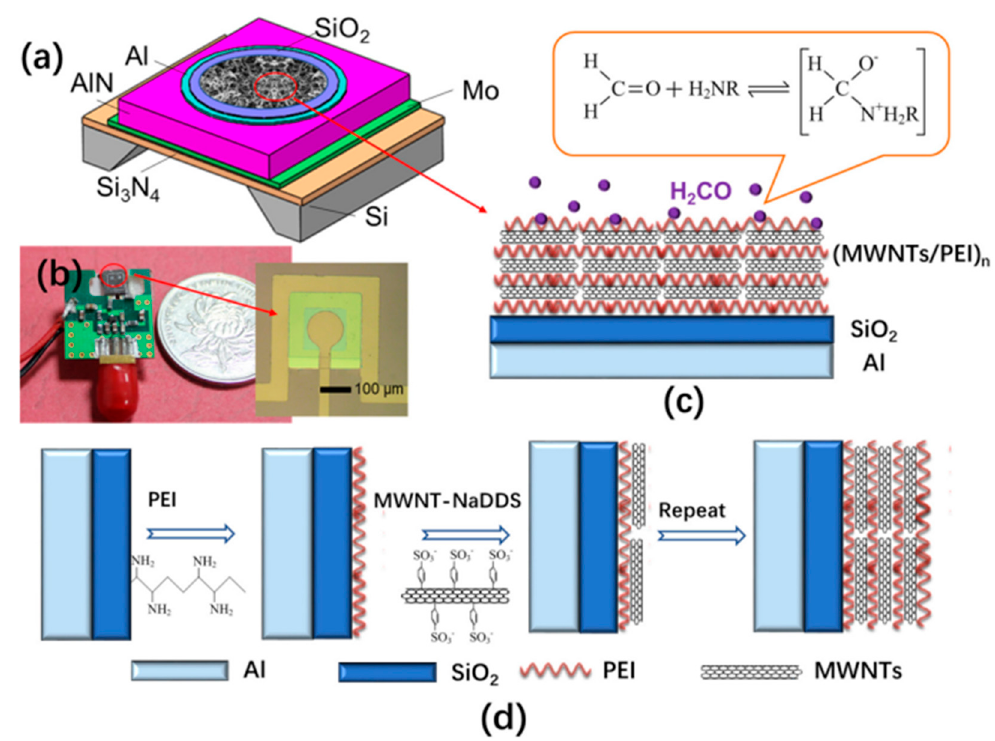
Figure 9. ( a ) Schematic structure of the FBAR sensor, ( b ) photographs of the fabricated device on a PCB, ( c ) (MWNTs/PEI) n multilayer assembled on the top of FBAR, ( d ) LBL assembly process of the (MWNTs/PEI) n multilayer [75] . (Copyright (2018) IOP Publishing Ltd.).